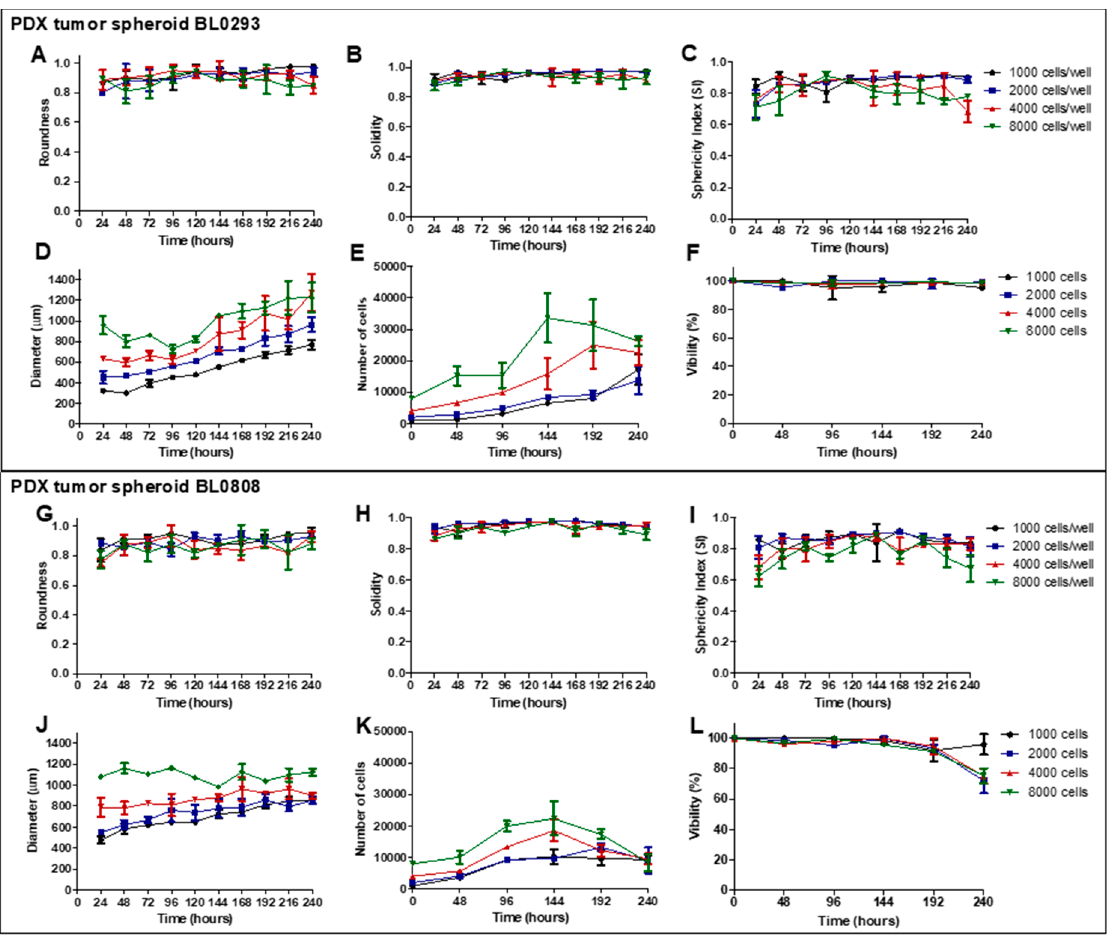
Figure 2. Characterization of PDX tumor spheroids BL0293 ( A–F ) and BL0808 ( G–L ) based on the evaluation of shape parameters (roundness, solidity, and sphericity index (SI)), size (Feret’s diameter), cell growth, and viability for 240 hours of culture, starting from different cell-seeding densities. Data displayed as mean ± SD referring to one experiment with three technical replicates (wells) per condition ( n = 3).